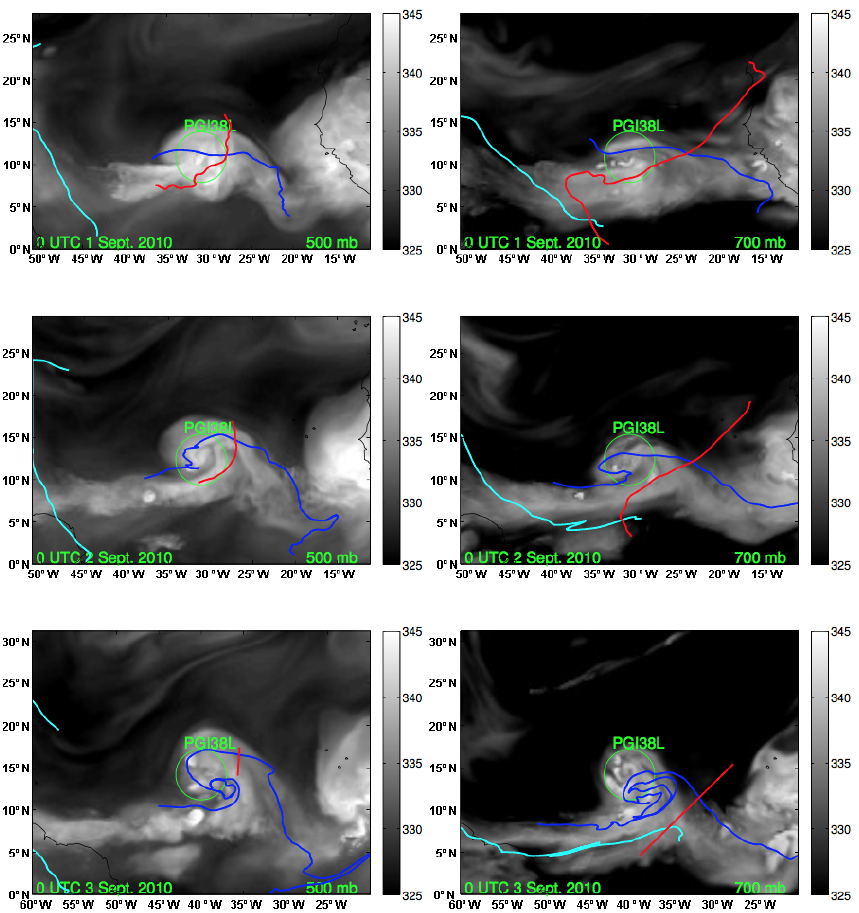
Figure 6. Lagrangian manifolds are overlaid on θ e fields at 500hPa (left column) and 700hPa (right column) from 1 to 3 September. Stable manifolds are red, and unstable manifolds are blue and cyan. The manifolds indicate that the pouch had a hyperbolic point to the east, but was open to environmental air to the